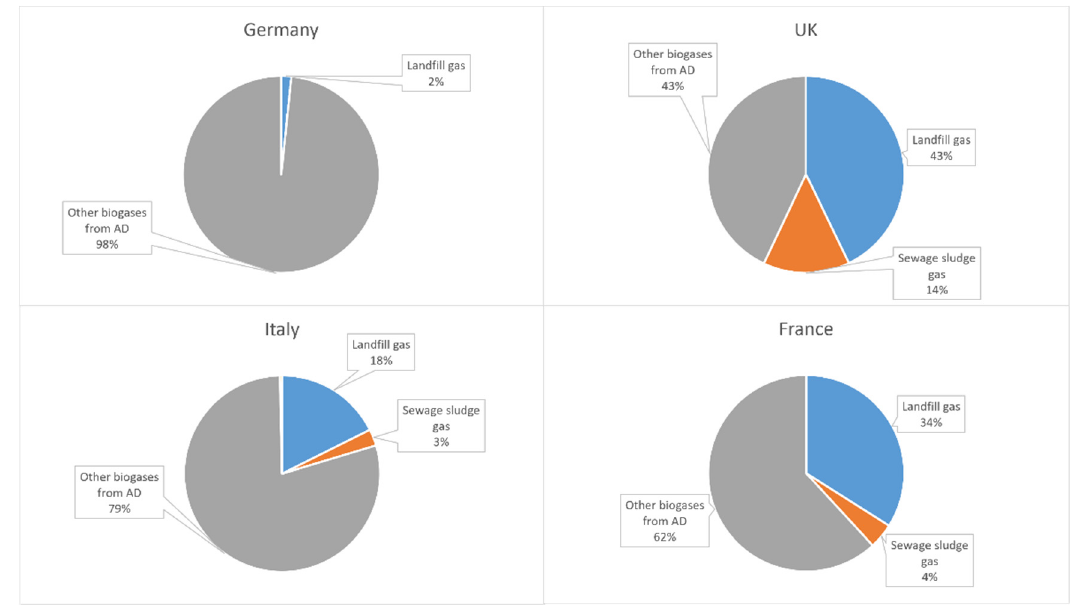
Figure 7. Leading countries in biogas production (according to [135]).